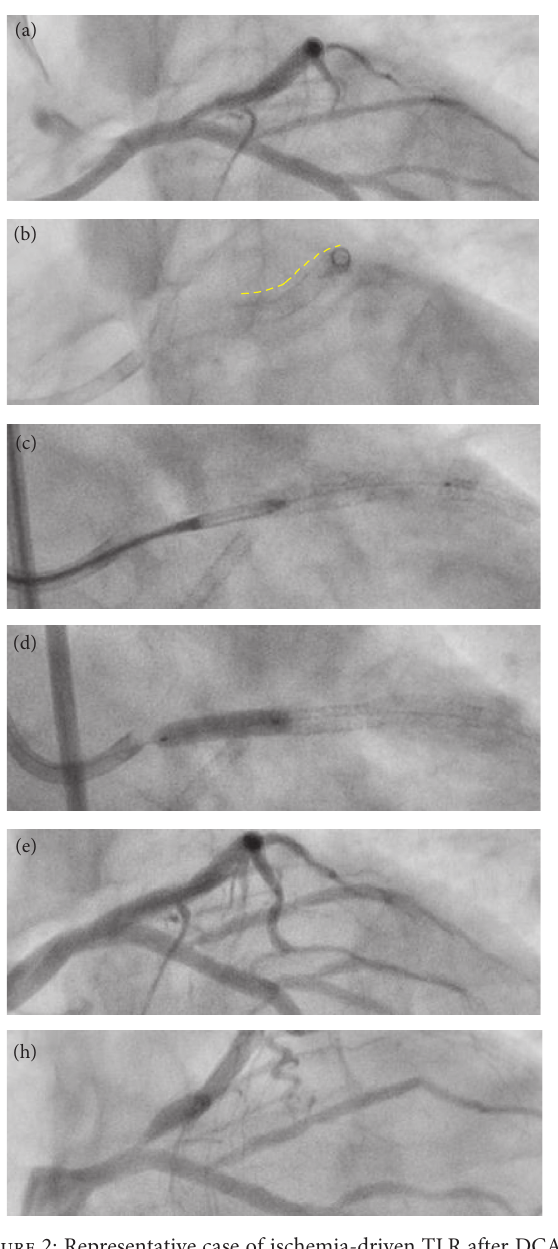
Figure 2: Representative case of ischemia-driven TLR after DCA for stent edge restenosis at the LAD ostium: (a) preprocedure coronary angiography, (b) yellow dotted line indicates previously implanted stent, (c) DCA was performed for stent proximal edge restenosis at the LAD ostium, (d) DCB angioplasty was performed, (e) postprocedure coronary angiography, (f) IVUS findings at preprocedure shows %PA was 61.4%, (g) IVUS findings after DCA shows %PA decreased to 25.9%, and (h) follow-up coronary angiography at 10